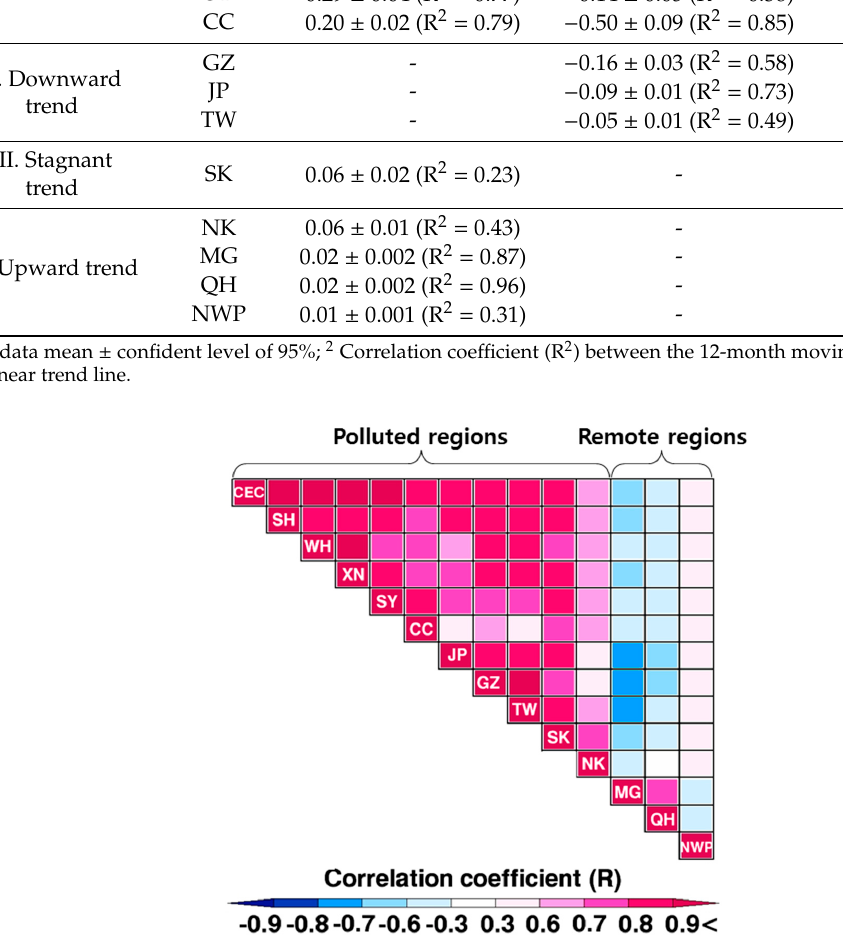
Figure 4. Matrix view of the interregional correlations for monthly Ω between fourteen regions. Colors represent the correlation coefficients (R). Correlation rages between − 1 and 1. Correlation close to 1 (or − 1) indicates a more positive (or negative) relationship between the Ω over two regions. Correlation of 0 means no linear relationship. Coefficients from 0 to 0.3 (or from 0 to − 0.3) indicate a week linear relationship. Coefficients from 0.3 to 0.7 (or from − 0.3 to − 0.7) indicate a moderate linear relationship. Coefficients from 0.7 to 1.0 (or from − 0.7 to − 1.0) indicate a strong linear relationship. There are other positive linear relationships of moderate strength between NK and other polluted regions (except for SK), which ranged from 0.56 to 0.69. As discussed, insufficient electricity and inactive energy consumption are possibly related to the low correlation coefficient in North Korea, which were indirectly confirmed by the night-light images from satellite observation [52,58]. The analysis also showed lower correlations from NWP with each polluted region because NO x over the ocean is irregularly emitted from marine diesel engines and supplied by occasional long-range transports from inland [59,60]. On the other hand, there were moderate negative linear relationships (bluish color in Figure 4) for MG and QH, indicating that the monthly variations of Ω are absolutely the opposite of those over the polluted regions. The fact was found in Figure 5, showing the monthly variations of the tropospheric NO 2 columns normalized to the 10-year average. Thus, Ω over MG and QH were high during the warm seasons and were low during the cold seasons in Figure 5, unlike those over the polluted regions. As intensively discussed in other studies [8,9,14,15,31], the low levels of atmospheric NO 2 during the warm seasons are caused by the active NO x destruction through the reaction of NO 2 +OH+M → HNO 3 in the urban polluted regions. In contrast, the biogenic soil NO x emissions can lead to the high levels of Ω over the rural areas (e.g., MG and QH) because microbiological activity in soil is active during the warm seasons [61–64]. Recently, Han et al. reported from their modeling study that atmospheric NO 2 decomposed thermally from Peroxyacetyl Nitrates (PANs) is also a crucial contributor to the high NO 2 (by up to 51%) during the warm seasons in the remote continental regions of Mongolia [31].